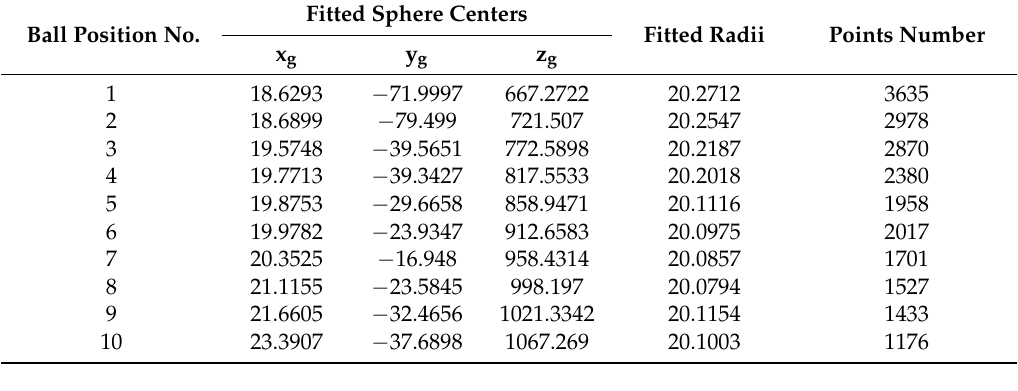
Table 1. The 10 fitted sphere centers galvanometer coordinates, radii (mm), and detected points numbers.